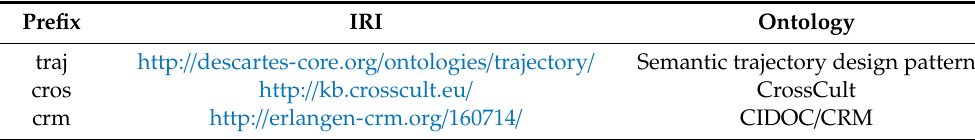
Table 1. Ontologies used for the framework